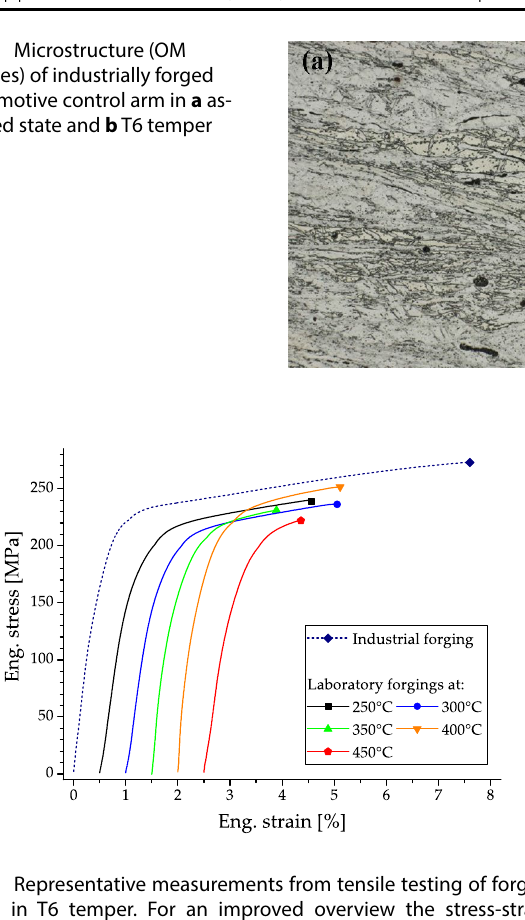
Table 1 Microstructural and mechanical properties of AXMZ1000 forged parts in peak aged state (T6), including standard deviation